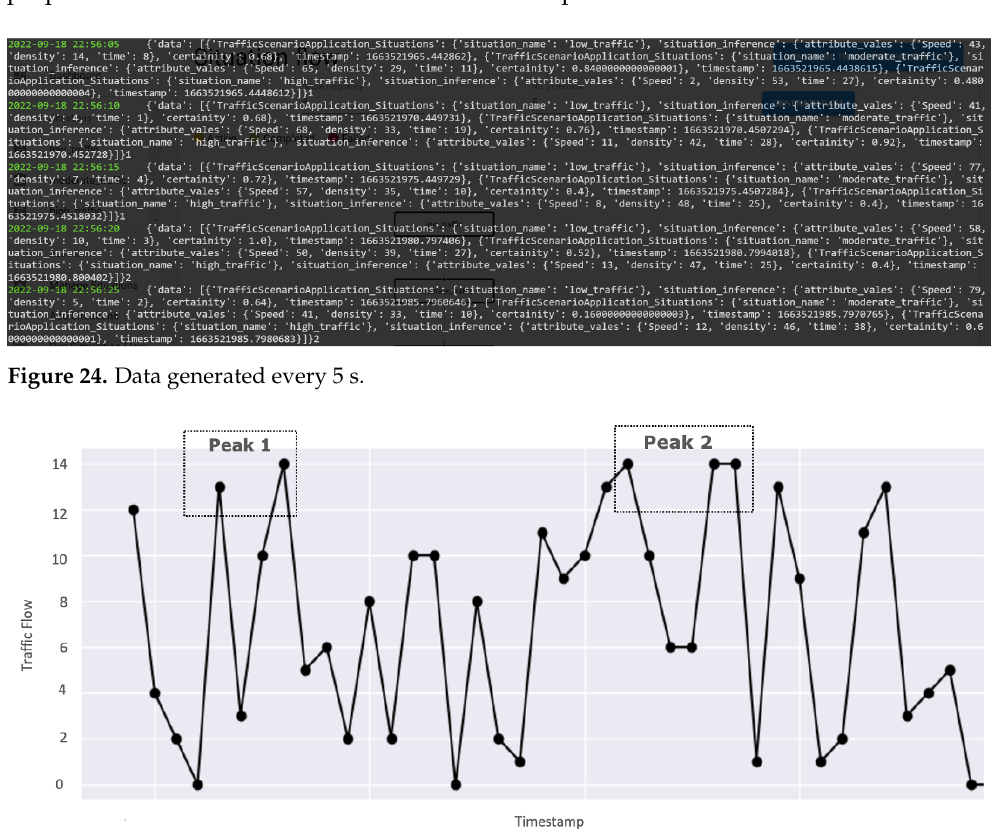
Figure 25. Visualizing generated data of a traffic monitoring